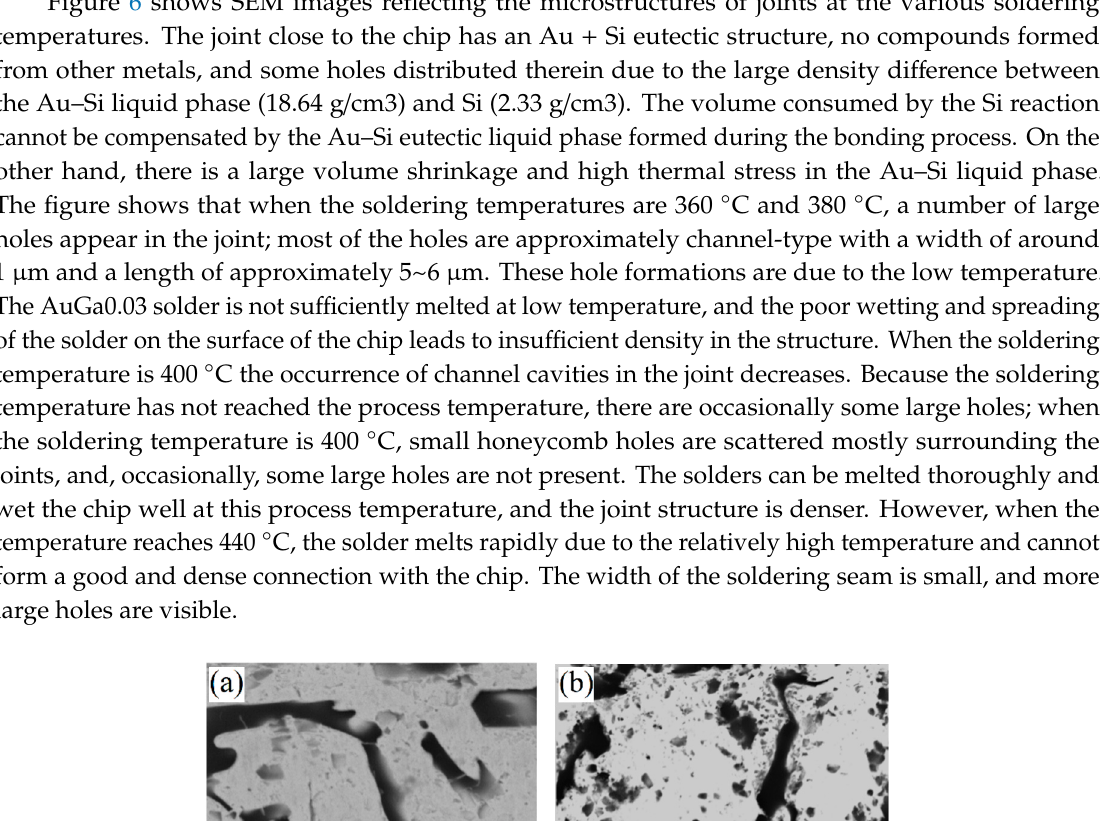
Figure 5. Patterns of joints at different soldering temperatures.